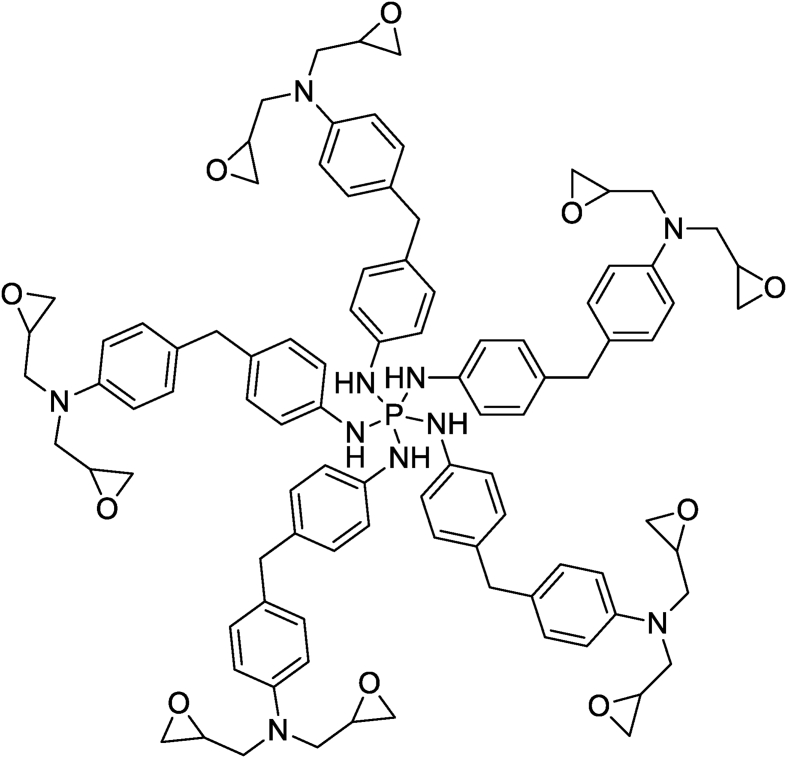
Structure of DGPMDAP [39].